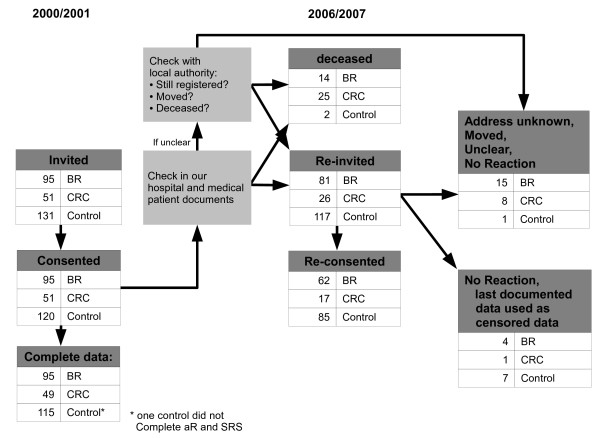
Flow chart of participants recruiting 2000/2001 and 2006/2007.